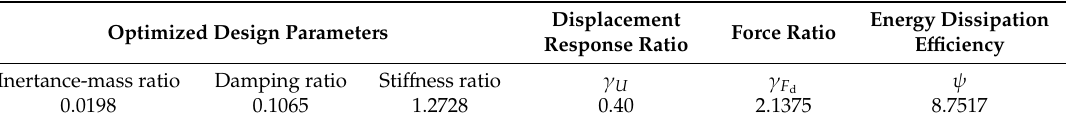
Figure 8. Pareto optimal front. Table 1. Results of performance-based design optimization.